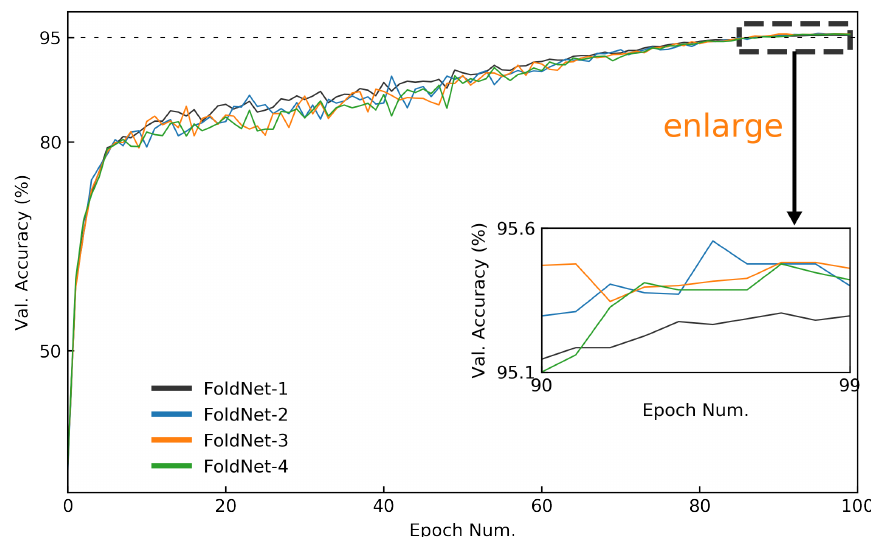
Figure 8. Validation-accuracy curves of FoldNet for CIFAR-10 dataset when hidden dimension h = 256 and network depth n = 48. The validation accuracy curves of the last 10 epochs are enlarged to compare the accuracies of FoldNet- d more clearly.